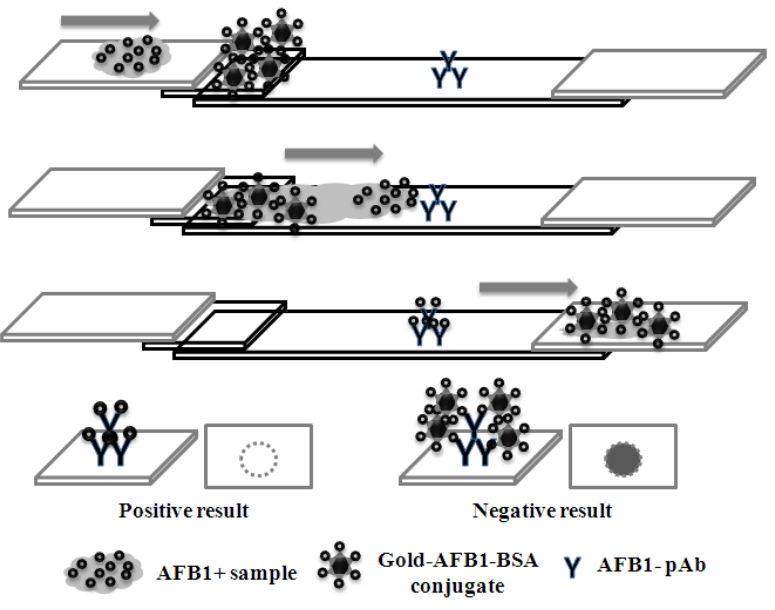
Figure 1. Schematic description of the one-dot LFIA for AFB1.